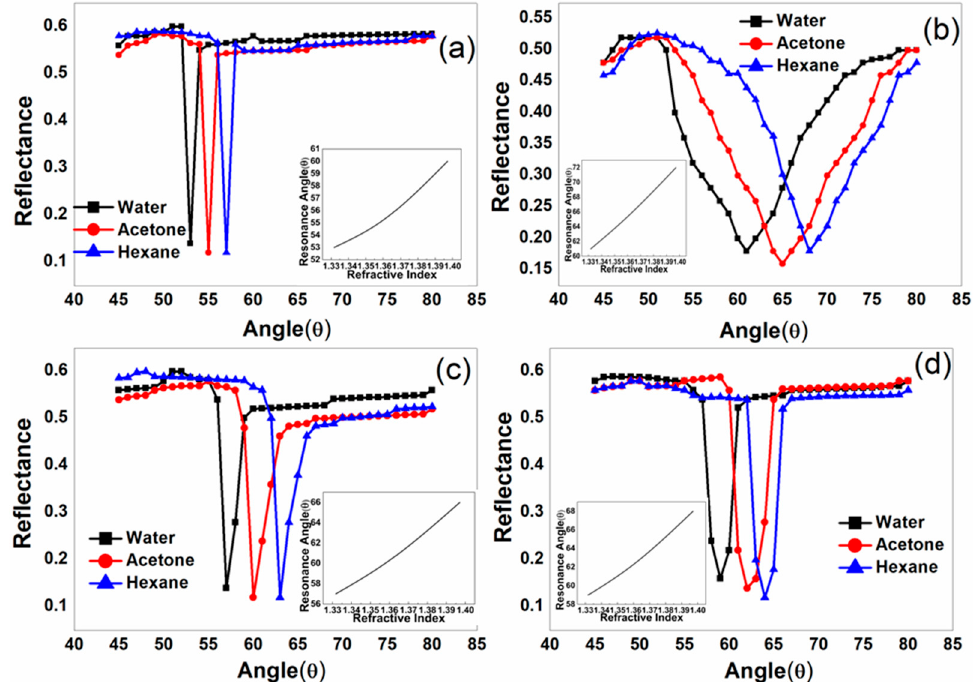
Figure 5. Data against standard test samples of water, acetone and hexane for sensors ( a ) Ag-I ( b ) Au-II ( c ) Ag-Au-III ( d ) Ag-Au-IV. Embedded figure plots the changes of resonance angle with the refractive index of the medium. Corresponding to a higher change in refraction index of the sample, the resonance happened at a higher angle of incidence. Table 2. Experimentally Measured FWHM for Different Sensors.